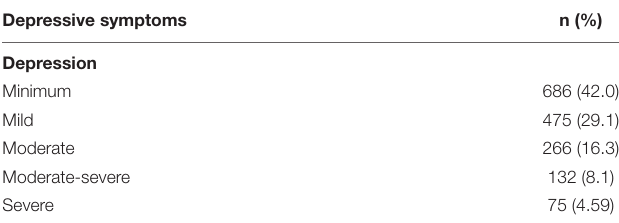
TABLE 3 | Depressive symptoms in Peruvian university students during the COVID-19